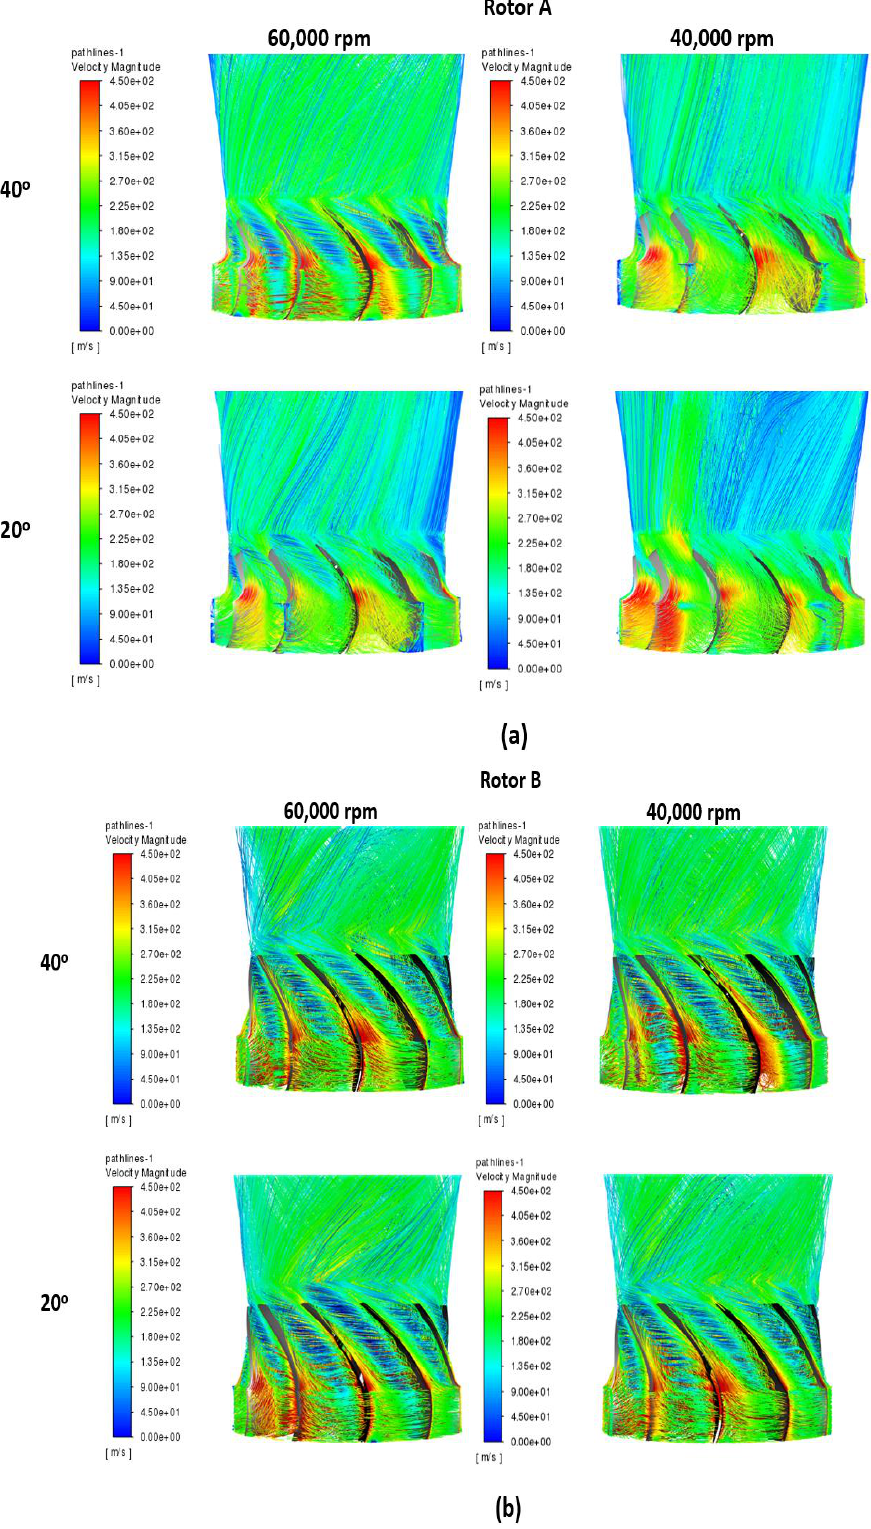
Figure 29. The velocity streamlines at the outlet from the first-stage rotor at two different turbine speeds and VTG positions for: ( a ) rotor A and ( b ) rotor B